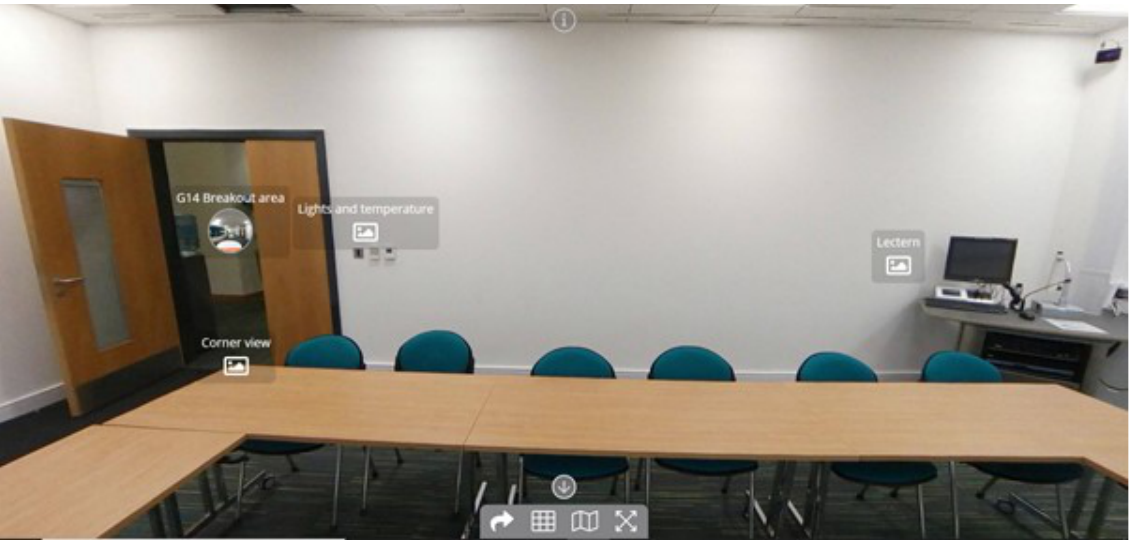
SeekBeak® 360° Room: Conference Room